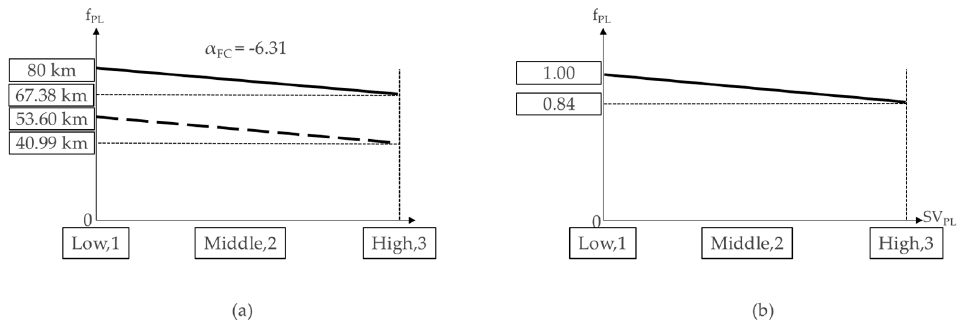
Figure 15. Adjustment factor development ( a ) and standardization for the existence ( b ) of the level of parking.